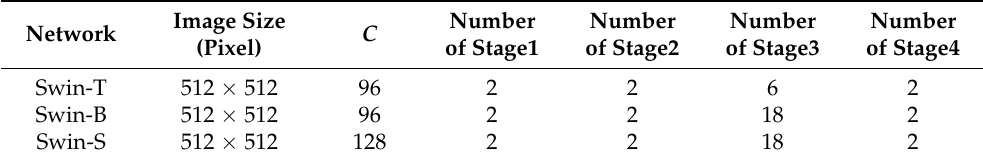
Table 2. Parameters of three Swin-Transformer network variants.